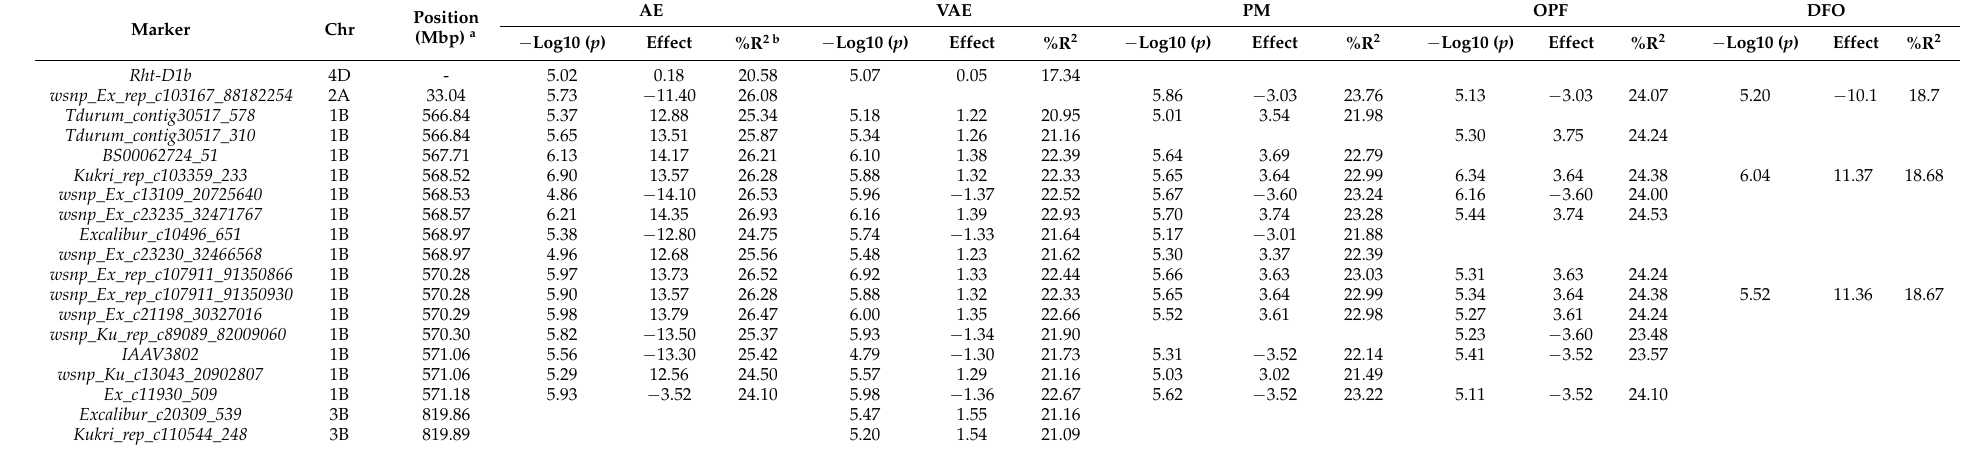
Table 1. Significant common markers associated with anther extrusion, visual anther extrusion, pollen mass, openness of the floret and duration of floret opening at FDR ≤ 0.05.